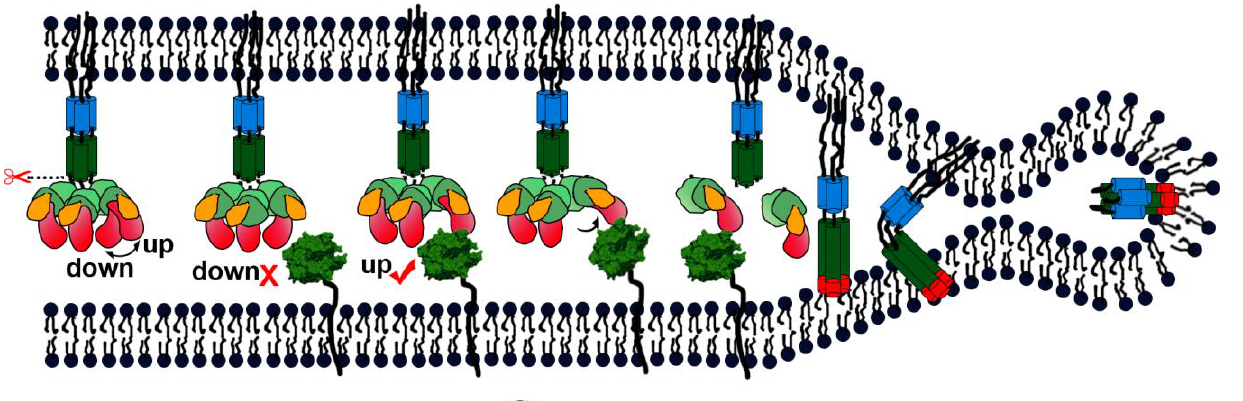
Figure 4: Courtesy reference number 24. A cartoon representation showing the pre- to post-fusion transition of the SARS-CoV S glycoprotein. The “down” to “up” transition of the receptor-binding domain (CTD1) allows receptor binding. The binding to ACE2 opens up CTD1 and CTD2, promotes the disassociation of the S1-ACE2 complex from the S1/S2 cleaved S glycoprotein, induces the pre- to post-fusion transition of the S2 subunit, and initiates the membrane fusion.